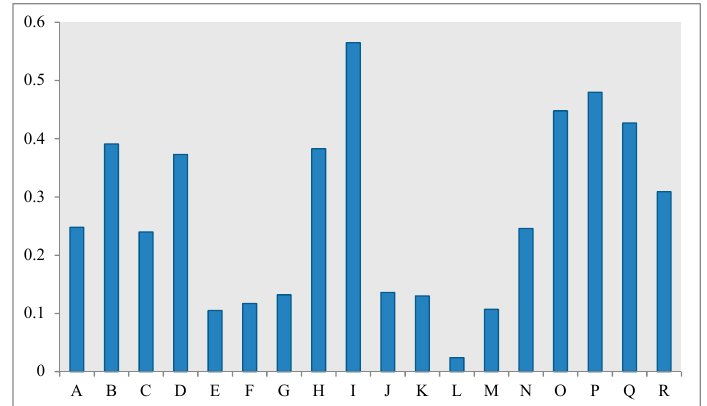
Figure 6. The relative importance of conditioning factors in the IoE model. A: landuse / land cover, B: Soil type, C: lithology, D: topography wetness index (TWI), E: stream power index (SPI), F: aspect, G: convergence index (CI), H: elevation, I: drainage density, J: distance to stream, K: distance to stream, L: slope length (LS), M: plan curvature, N: profile curvature, O: rainfall, P: slope, Q: terrain ruggedness index (TRI), R) topography position index (TPI).